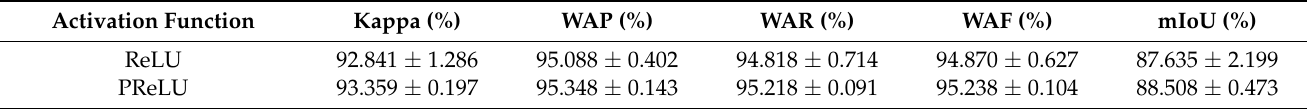
Table 7. Comparison of segmentation performance of the model with different activation